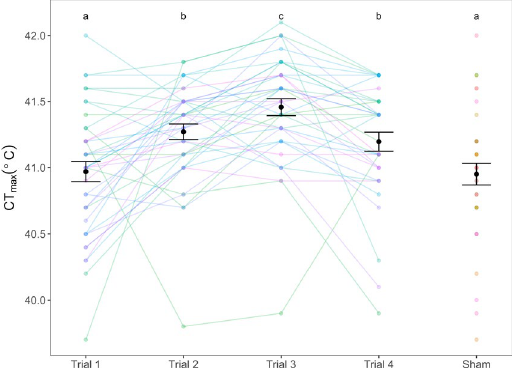
Figure 1. Critical thermal maxima, CT max (°C), for zebrafish (n = 40) repeatedly measured over four trials one week apart, as well as for the sham fish (n = 38) whose CT max was recorded simultaneously as Trial 4. CT max was measured at a thermal ramping rate of 0.3 °C min − 1 . Letters a, b & c illustrate statistically significant differences between trials. Coloured points and lines represent individual fish’s CT max . Black points and bars show the mean CT max ± s.e.m. for each trial.